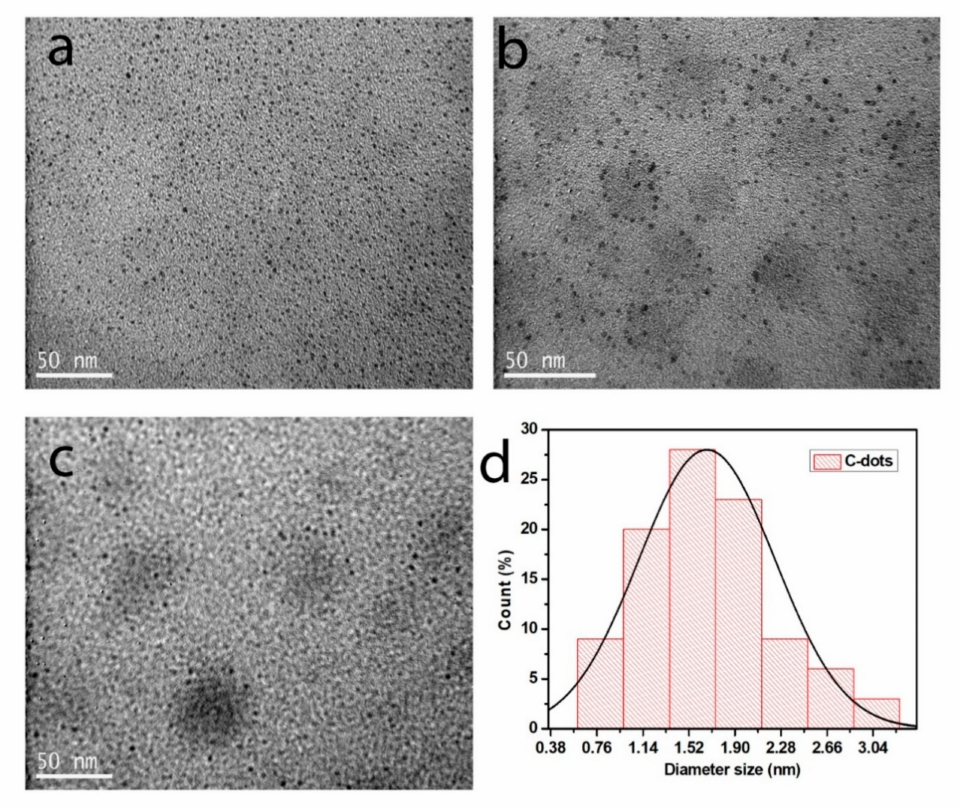
Figure 3. TEM images of C-dots ( a – c ) and diameter size distribution diagram ( d ).